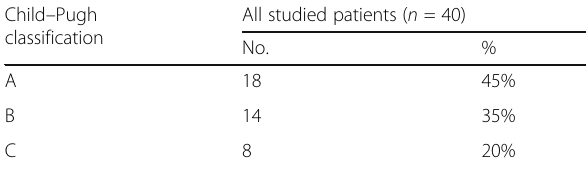
Table 1 Demographic data of the studied patients (no. = 40) Demographic Data